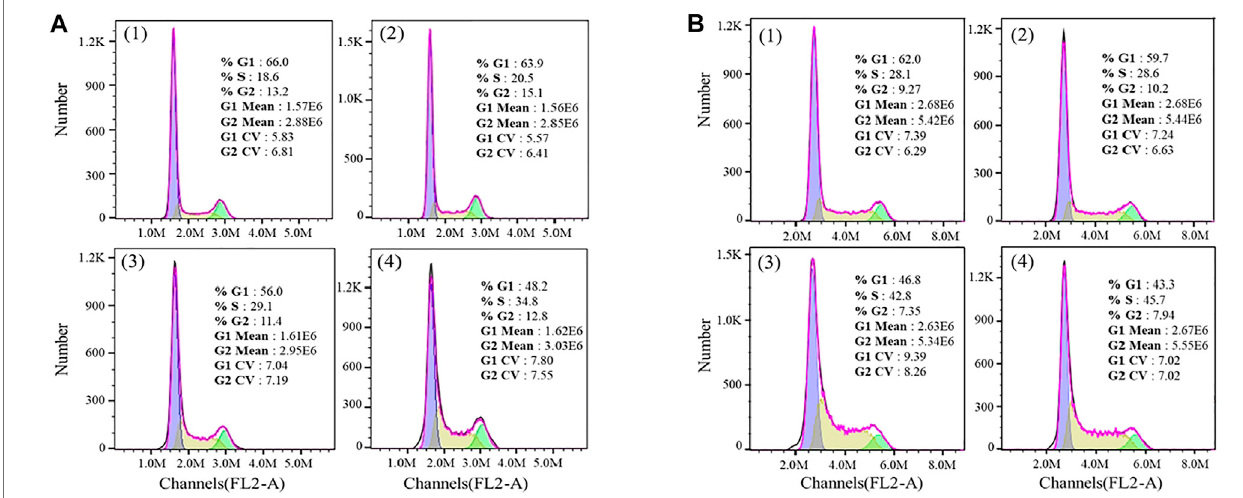
FIGURE 8 | Effects of the Fe complex (A) and the HSA Fe complex adduct (B) on the cell cycles. (1: 0 μ M; 2: 0.2 μ M; 3: 0.5 μ M; and 4: 0.8 μ M).